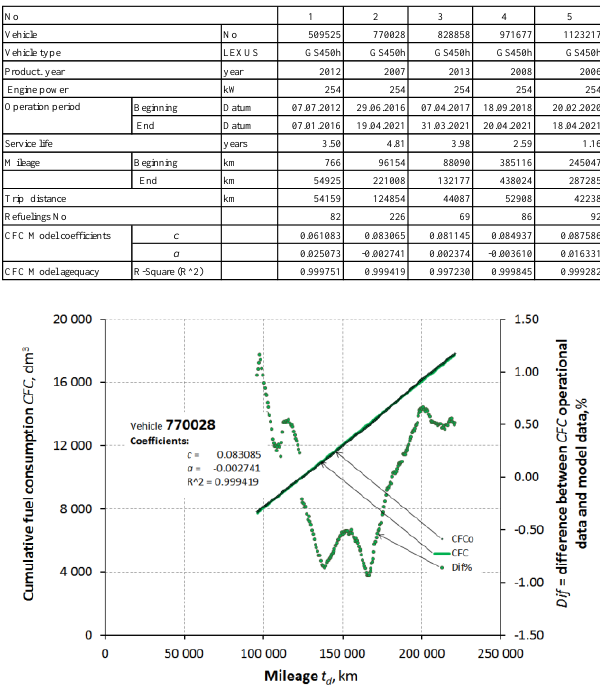
Table 1. Operational data and calculation results of the analyzed cars